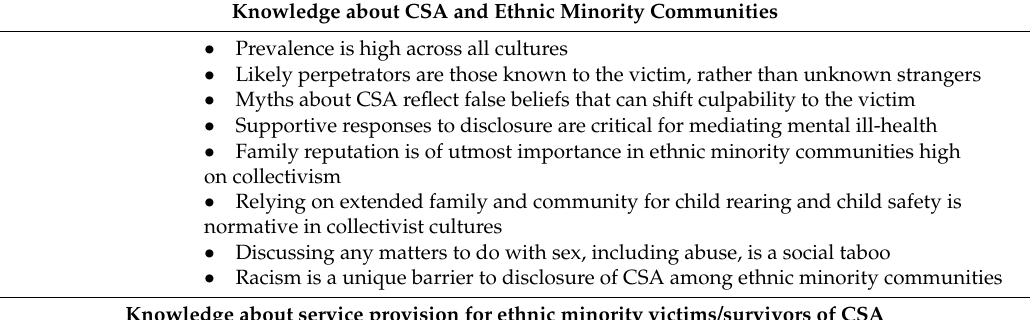
Table 1. Full program scope /